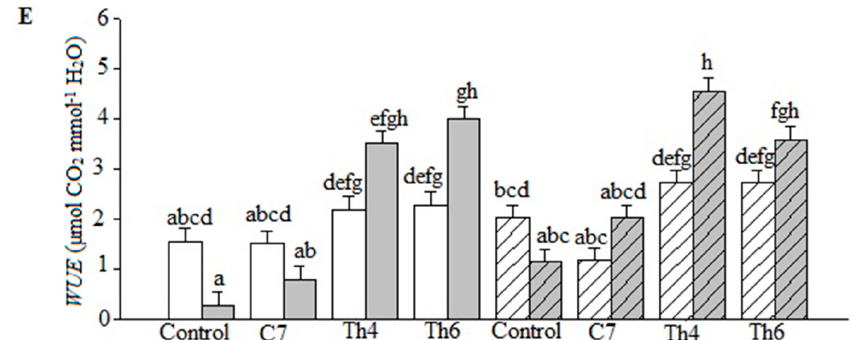
Figure 2. Photosynthetic parameters of wheat cultivars Shimai and Xiaoyan60 under the microbe and salt stress treatments. Control, C7, Th4, and Th6 represent uncoated seeds, C7 seed coating, Th4 seed coating, and Th6 seed coating, respectively. The salt stress levels were 0 mM NaCl and 200 mM NaCl. The values are the means of three replicates ± SE ( n = 3). ( A ) Net photosynthesis ( A ), ( B ) stomatal conductance ( g s ), ( C ) intercellular CO 2 (C i ), ( D ) transpiration ( E ), and ( E ) water use e ffi ciency ( WUE ). The wheat cultivars: Shimai in white-gray bars and Xiaoyan60 in white-gray bars with course pattern. Di ff erent letters denote significant di ff erences between the treatments and the cultivars according to Tukey-adjusted comparisons ( p < 0.05). Means sharing a letter are not significantly di ff erent. The leaf WUE was significantly ( p < 0.01) correlated with all main factors (cultivar, microbial strain, and salt stress), with an interactive e ff ect of microbial strains and salt stress (Table 3). Under stress Table 3. Photosynthetic parameters of two wheat cultivars (C) in response to microbial treatment (M), conditions, WUE was found to be higher in seedlings grown from Th4 and Th6 irrespective of cultivar salt stress (S), and their interaction.